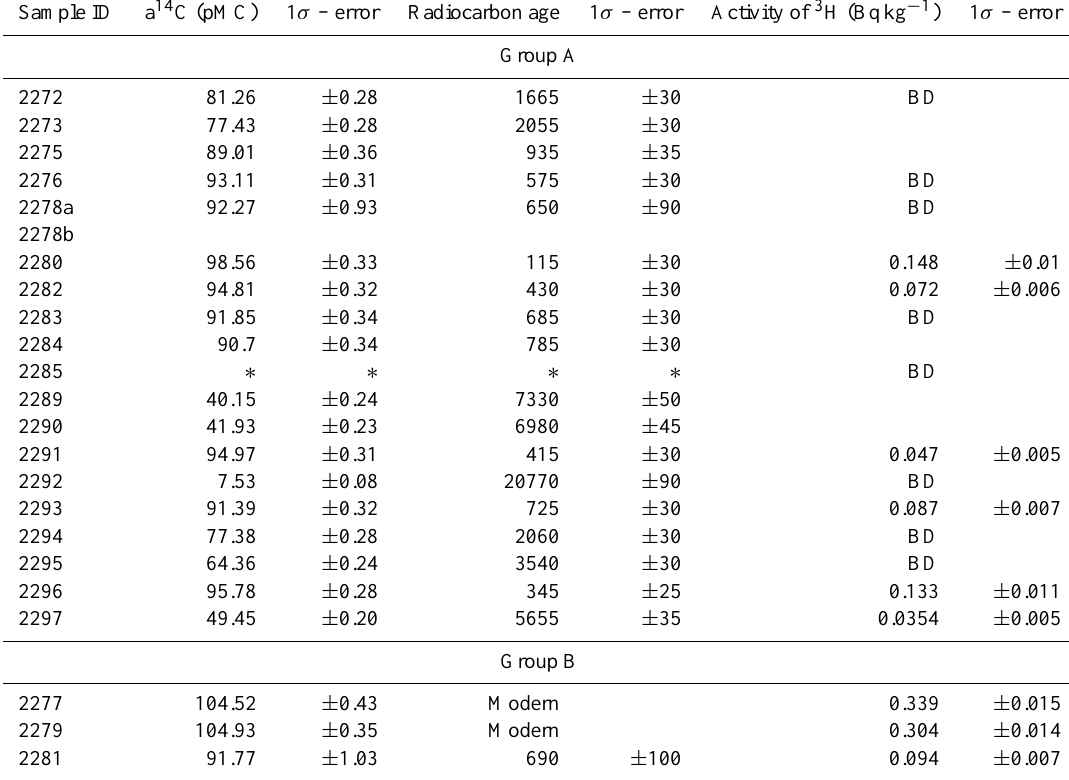
Table 2. Groundwater dates. Samples with 14 C activity > 100pMC are younger than 1950. Samples with measureable tritium contain groundwater < 50yr old, in some cases mixed with older groundwater (pMC <